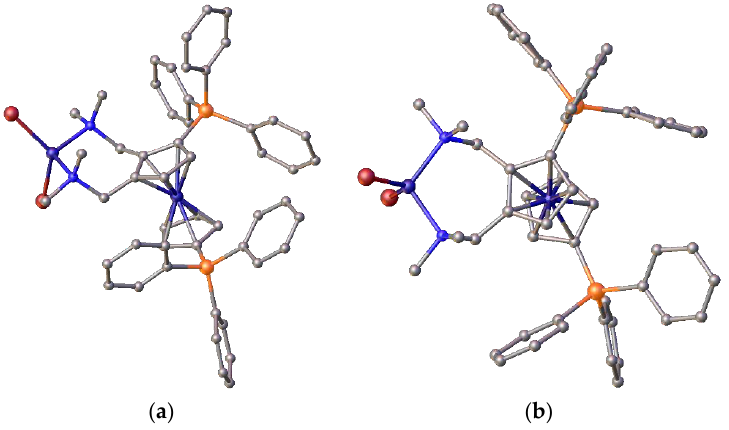
Figure 13. ( a ) Side and ( b ) top views of the tetrahedral NiBr 2 complex of the bis-methylamine pre-